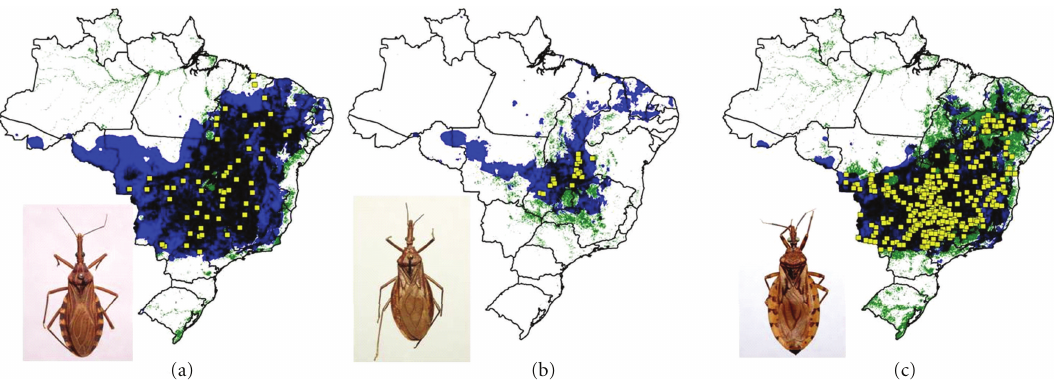
Figure 3: Ecological niche models projected as potential distributions for triatomine species in central Brazil. (a) R. neglectus , (b) T. costalimai , and (c) T. sordida